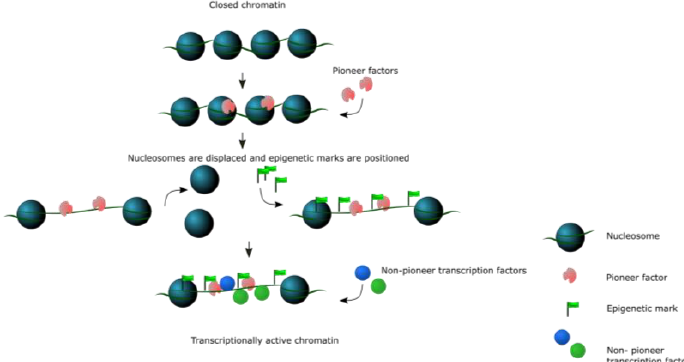
Figure 1. Activity of pioneer transcription factors. Pioneer factors bind nucleosomal DNA and open closed chromatin regions, e.g., by displacing nucleosomes, so that non-pioneer transcription factors can bind and regulate gene expression. In some cases, pioneer factors promote epigenetic marks deposition and r ender the ‘ pioneered sites ’ in an active state for a longer period of time (Tables 1 and 2).